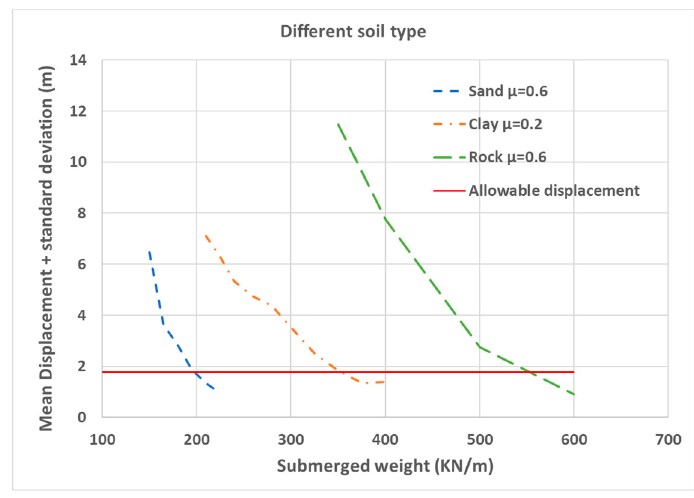
Figure 4. The mean displacement plus standard deviation for the clay, the sand and the rock cases. Table 8. The required submerged weight.